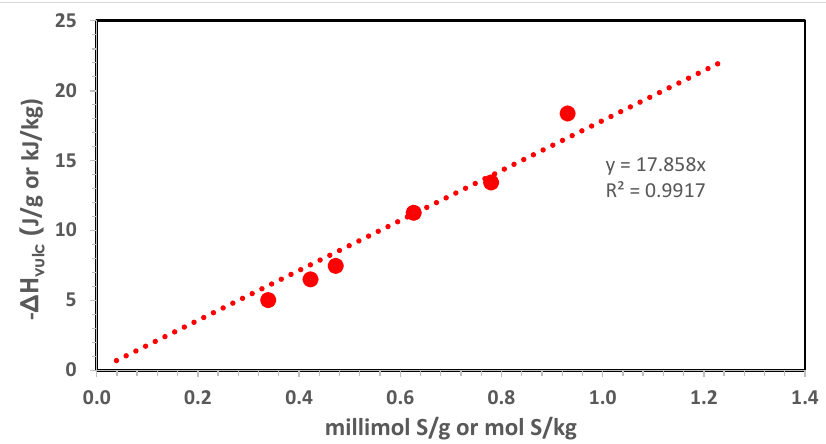
Figure 1. Vulcanization enthalpy measured with DSC on the following formulation: NR 80 phr; BR 20 phr; N326 carbon black 50 phr; paraffinic plasticizer oil 17 phr; stearic acid 3 phr; zinc oxide 3 phr; antioxidant TMQ 3 phr; accelerator NMOR 1.2 phr; sulfur variable: 1.2; 1.5; 1.68; 2.24; 2.8; 3.36 phr. All data taken from ref. [13] and re-elaborated in the present